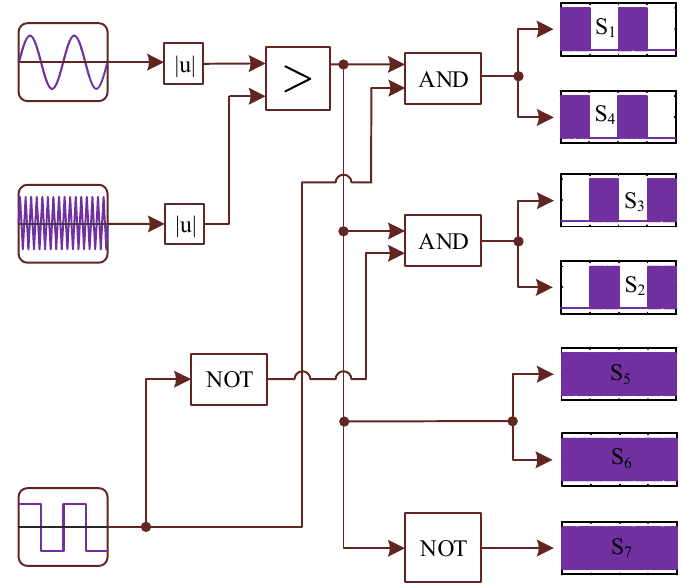
Figure 3. Gate pulse generation technique for the proposed transformer-less inverter.